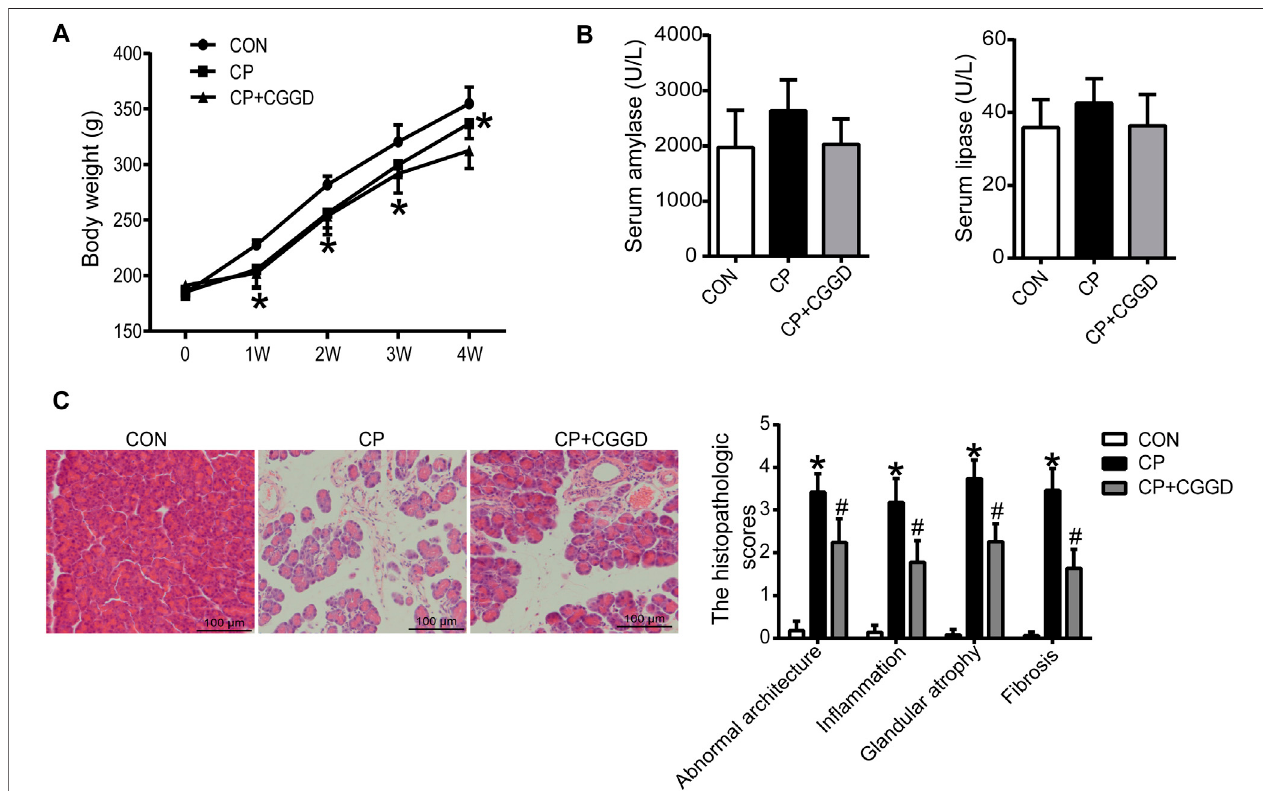
FIGURE 2 | Effects of CGGD on the body weight, serum amylase and lipase, and histological changes in CP rats induced by DBTC. (A) Body weight at different time points. (B) Serum amylase and lipase detected by ELISA. (C) Pancreatic morphological changes observed by H&E staining and scored by a pathologist (original magni fi cation, × 200). n (cid:2) 7 – 10, * p < 0.05 compared with the control group; # p < 0.05 compared with the CP